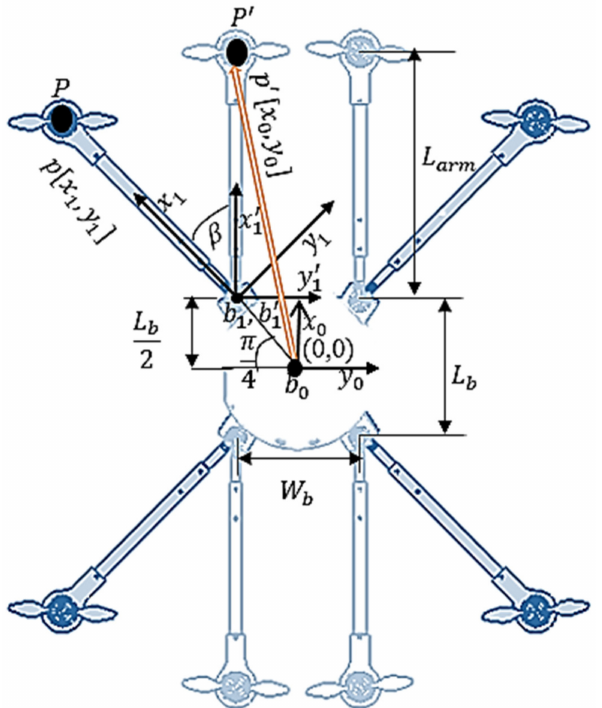
Figure 2. Morphed MUAV with Co-ordinate